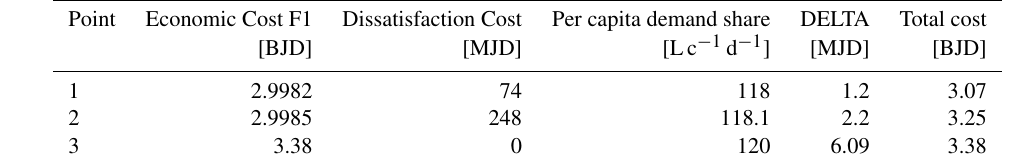
Table 1. Pareto optimal selection.